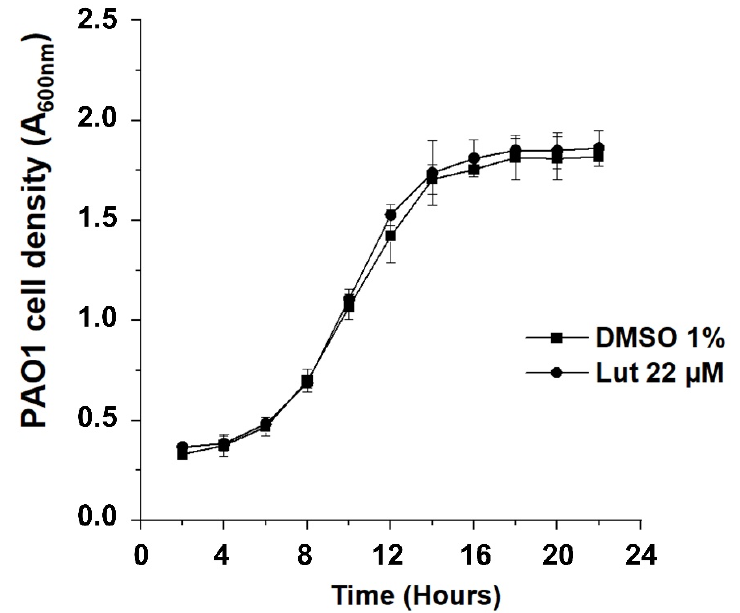
Figure 3. Effect of Lut on the growth kinetics of PAO1. Growth kinetics of PAO1 in presence of Lut at 22 µM or DMSO 1% over a period of 22 h under agitation by measuring the cell density of the bacterial growth at A600 nm. The bars represent the standard error of the mean. There were no statistical differences between the 2 conditions at any time point (n = 4) ( p- values > 0.01).